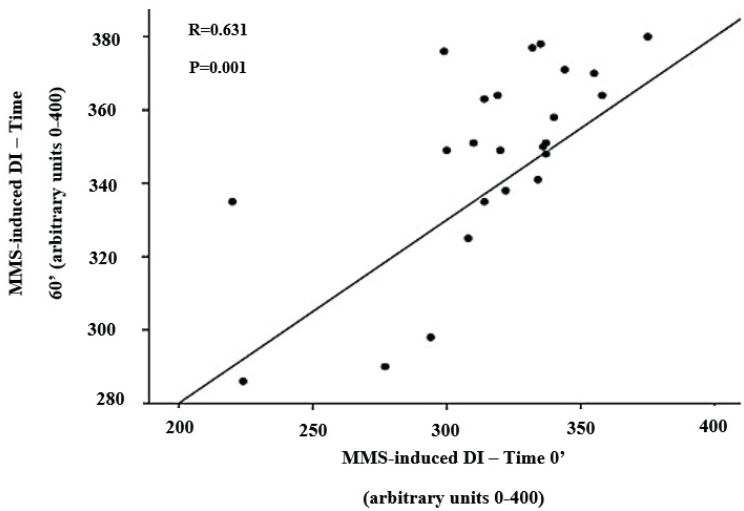
Figure 3 - Association between MMS-induced DI in DNA, at times 0 and 60 minutes, in patients with lung cancer. DI = DAMAGe index; MMS = methyl methanesulfonate; Spearman’s Correlation was